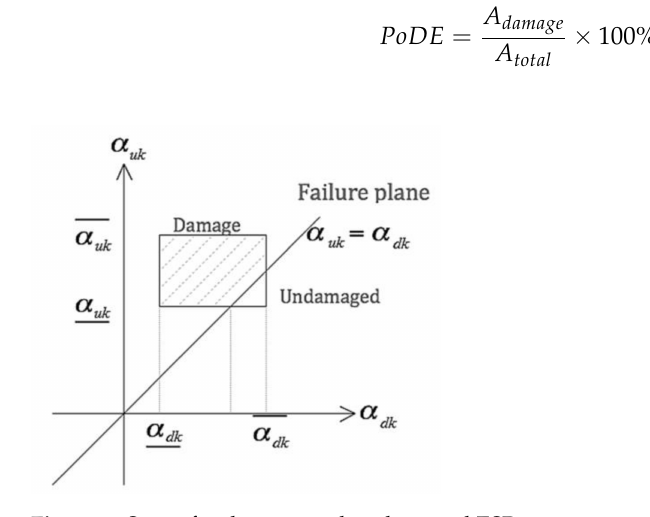
Figure 3. Space for damage and undamaged